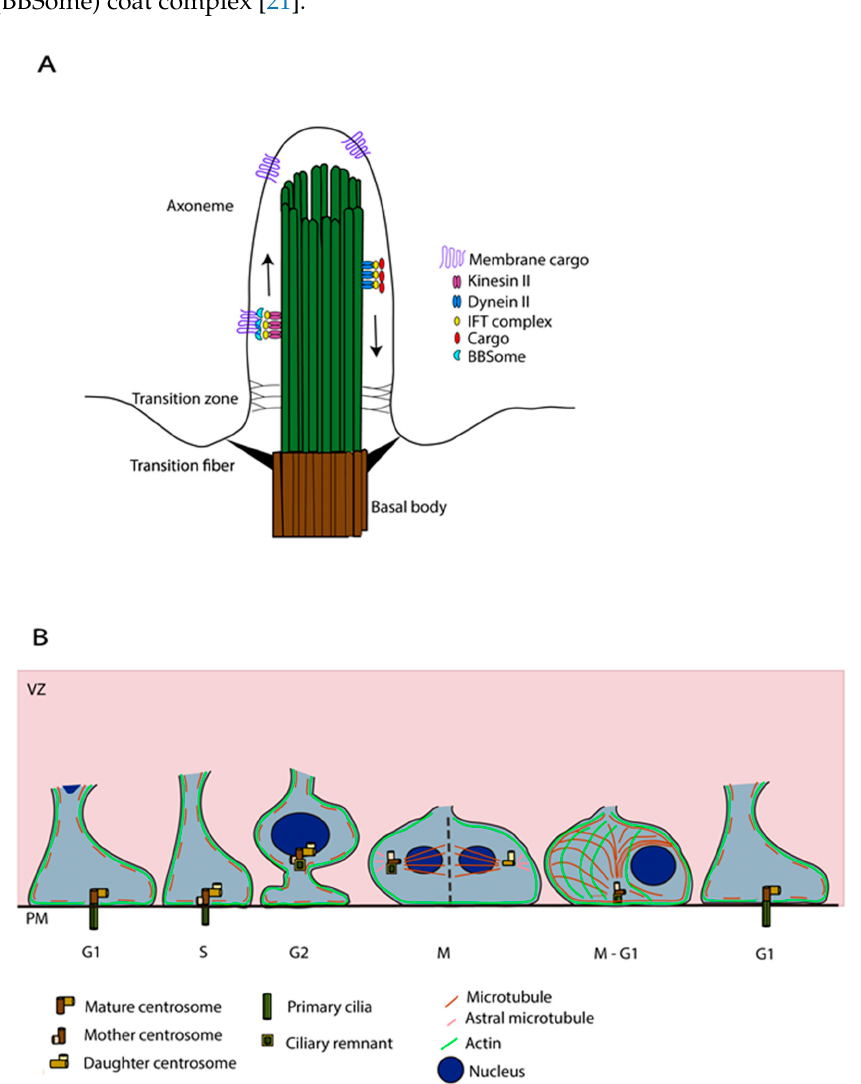
Figure 3. Upstream mechanisms of PC formation in aRG. ( A ) Schema showing the structure of PC, based on 9 + 0 array of MT doublets (green), anchored at the basal body (brown). Kinesin II motor proteins associated with the IFT complex support the anterograde transport of cargos, while dynein II motor proteins associated with IFT complex help with the retrograde transport of cargos. Association of IFT motors with the BBSome complex supports the transport of membrane cargos. The transition zone at the base of the PC helps block diffusion of cytosolic and membrane proteins. ( B ) Dynamics of PC and centrosomes in the VZ of the developing neocortex across the cell cycle. The PC is assembled across G1 interphase and starts going through the process of disassembly during S phase, before entering the Mitotic (M) phase when it is completely disassembled, or at times still carries the ciliary remnant (which can help establish the PC sooner in one of the progeny). During this PC assembly process, specific actomyosin contraction and MT stabilisation help drive the basal body to the apical pole to dock and initiate PC assembly (this schema related to cytoskeletal dynamics is adapted for neural progenitors based on the studies carried out in RPE1 cells [22]). PM. Plasma Membrane, VZ: Ventricular